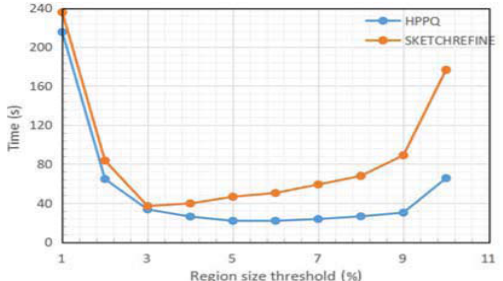
Fig. 11 Impact of threshold on real-world dataset.